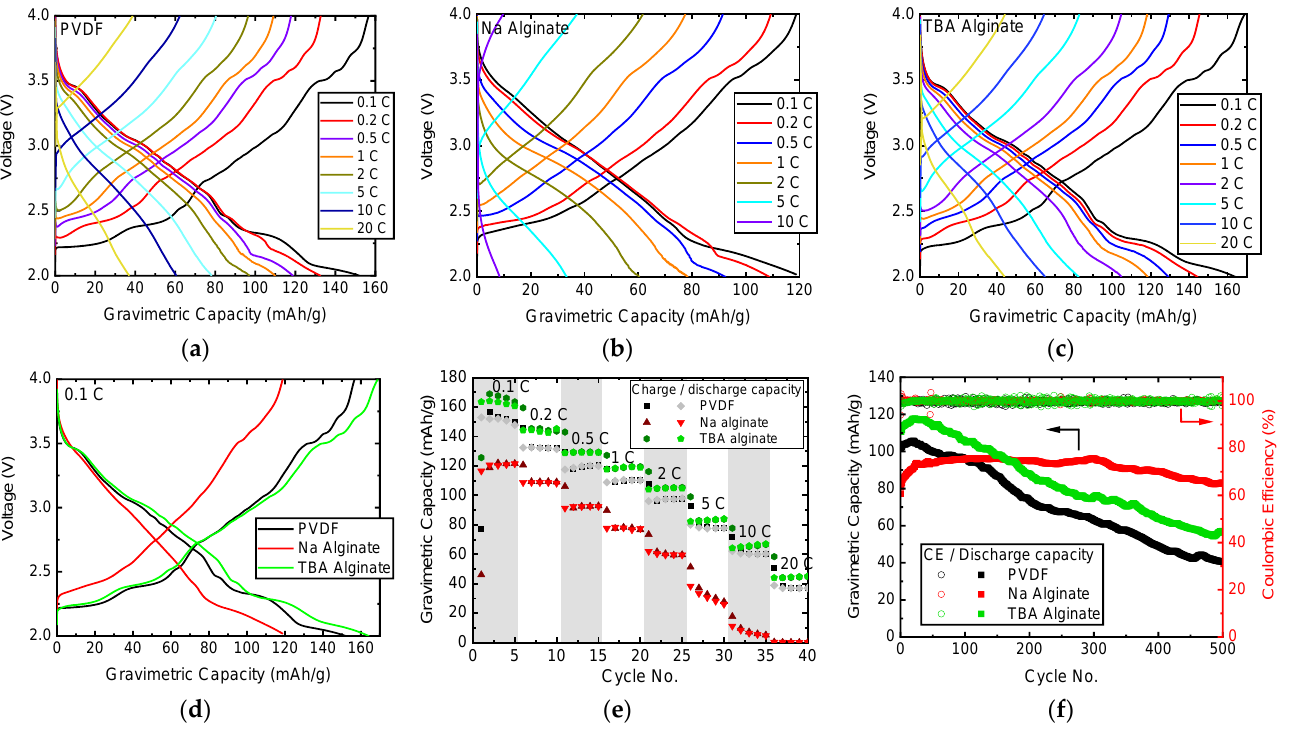
Figure 4. Electrochemical properties of Na 0.67 MnO 2 electrodes prepared with PVDF, Na alginate and TBA alginate binders: charge-discharge curves of Na 0.67 MnO 2 electrodes with ( a ) PVDF binder, ( b ) Na alginate binder, ( c ) TBA alginate binder; ( d ) charge-discharge curves at 0.1 C (17.5 mA/g); ( e ) rate capability of Na 0.67 MnO 2 electrodes; ( f ) cycle life of Na 0.67 MnO 2 electrodes cycled at 1 C; 1 C corresponds to 175 mA/g.